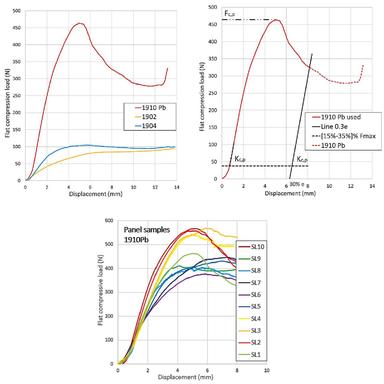
Representative example of the behavior curves of corrugated panels and measurements of their properties, as well as the behavior curves of ten 1910Pb panel samples under flat compression loading.